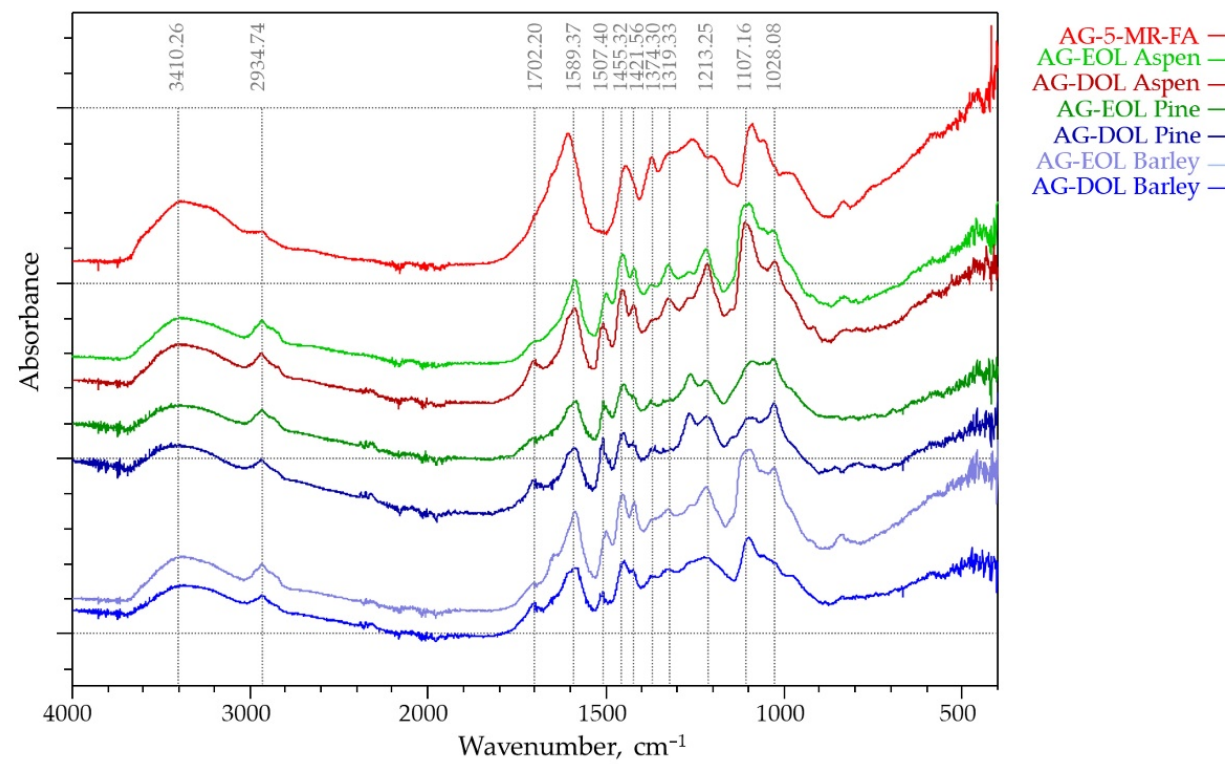
Figure 7. ATR FTIR spectrums of lignin-based (75% of the 5-MR was replaced by lignin) and AG-5- MR-FA aerogels.